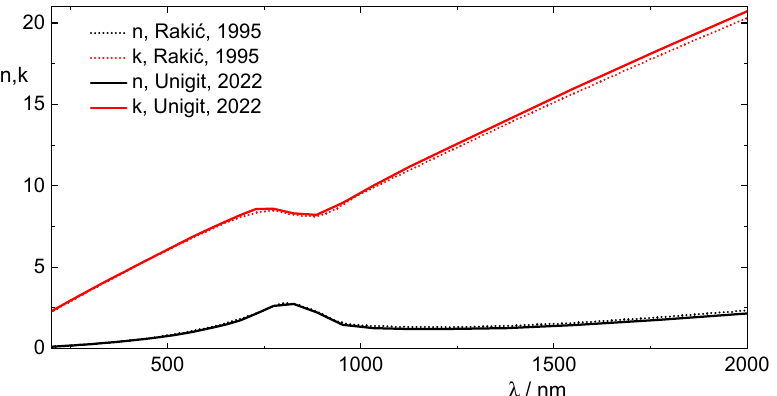
Figure 1. Reference data on the optical constants of aluminum (bulk or non-transparent films) [9,12].